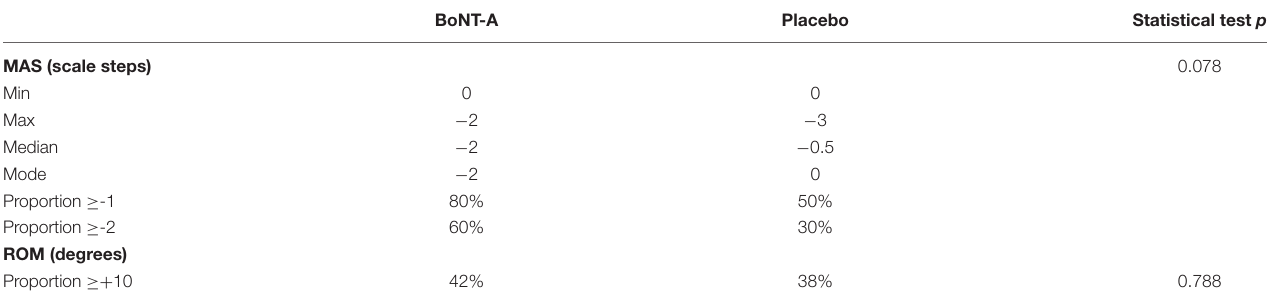
TABLE 5 | Differences in spasticity (MAS) and joint range of motion (ROM) after treatment, compared to baseline.